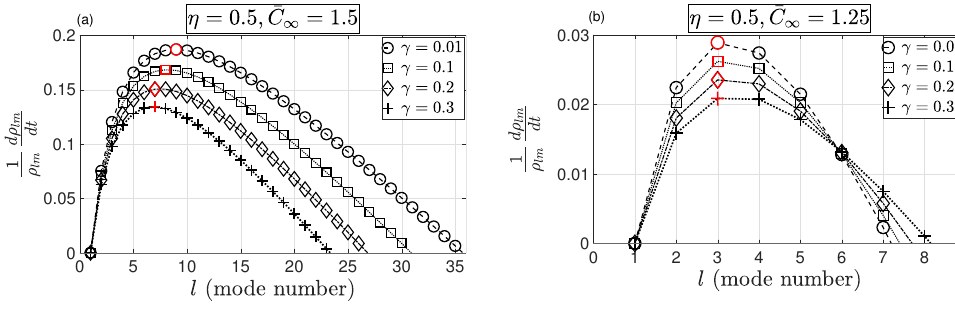
( θ , φ ) with respect to l (mode number) for γ = { 0.01, Figure 3. Growth rate of asymmetric modes Y m l 0.1,0.2,0.3 } and C ∞ = { 1.25,1.5 } . The mode number that maximized the asymmetric growth rate (maximal mode) is marked in red, indicating that increasing surface tension dropped the dominant mode from l = 9 to l = 7 for C ∞ = 1.5; however, it had a fixed value of l = 3 for C ∞ =